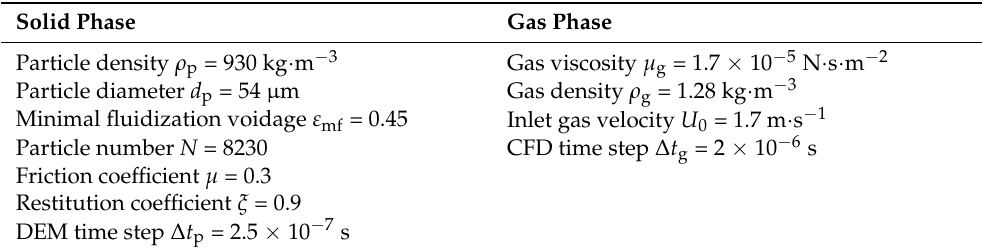
Table 1. Fixed parameters of solid and gas phases. Solid